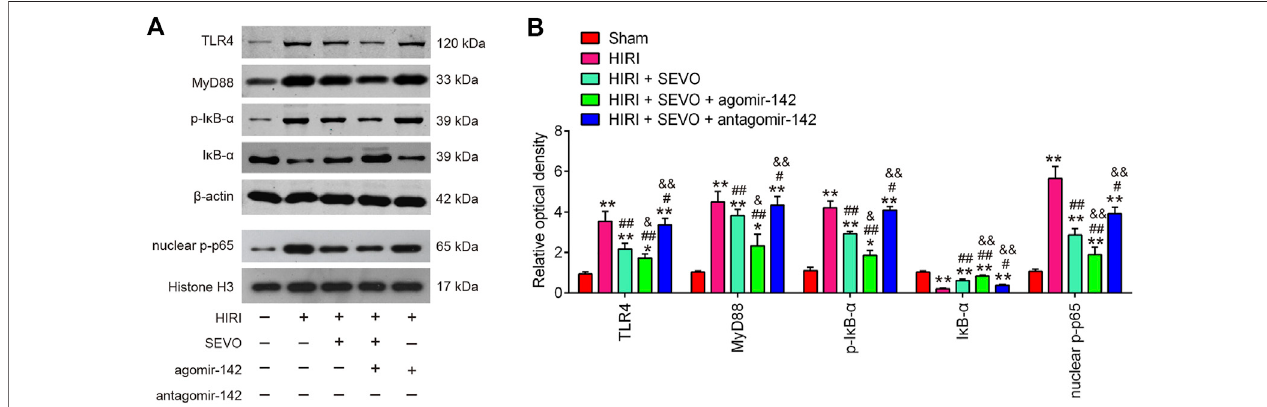
FIGURE7| SevopostconditioningblockedtheactivationofTLR4/MyD88/NF- κ Bsignalingpathway.TheagomiR-142andantagomiR-142wereinjectedintomice ( n (cid:2) 6/group),andthenthemiceweresubjectedtoischemia,post-treatmentwithinhalationof2%Sevofor2 himmediatelyattheonsetofreperfusion. (A,B) Theprotein expressions of TLR4, MyD88, p-I κ B- α and nuclear-p-p65 were detected by Western Blot. All data were measurement data which were expressed as mean ± standard deviation and analyzed by one-way analysis of variance. * p < 0.05, ** p < 0.01 vs. Sham group; # p < 0.05, ## p < 0.01 vs. HIRI group. and p < 0.01 vs. HIRI + Sevo group.